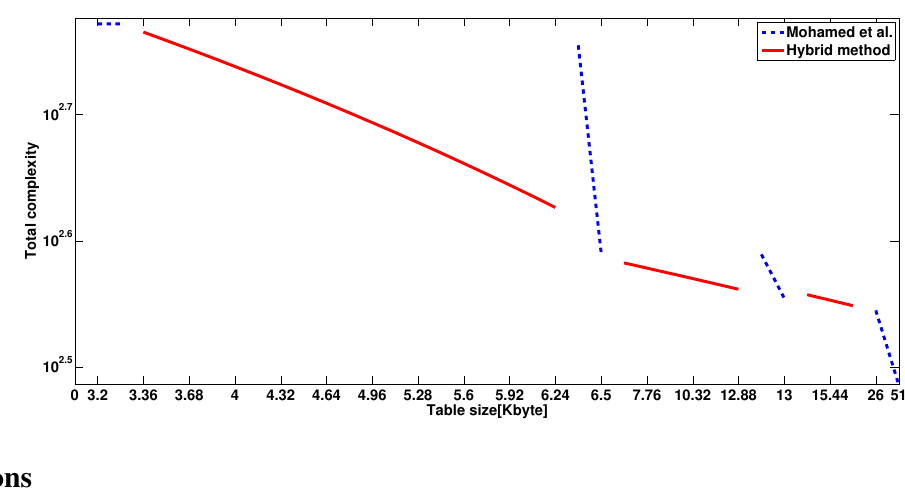
Figure 17. Performance of hybrid model using fine-tuned